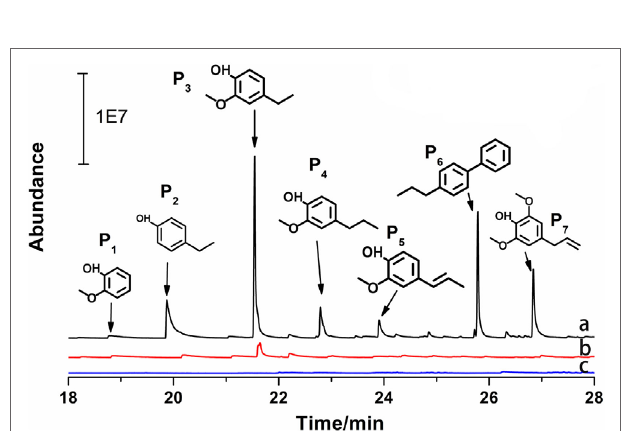
FIGURe 4 | GC–MS analysis of the products from lignin depolymerization on the three catalysts: (a) Pd-zeolite, (b) zeolite, and (c) Pd 2 + [Pd(NO 3 ) 2 solution] catalysts (reaction conditions: 200°C, 3.5 MPa H 2 , 3 h).